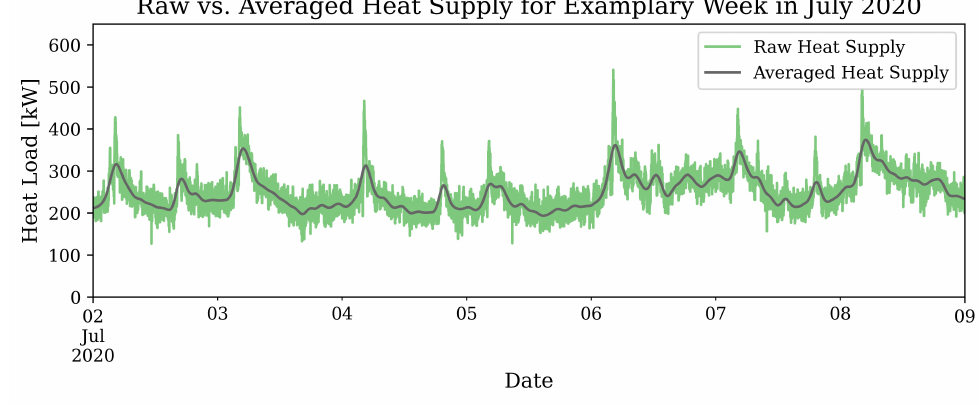
Figure 1. Comparison of raw heat supply measurements versus averaged heat supply in July. For raw measurements, heat supply of the different generation units was summed up. For the average heat supply, raw measurements were averaged by a 180 min gaussian window with 40 min standard